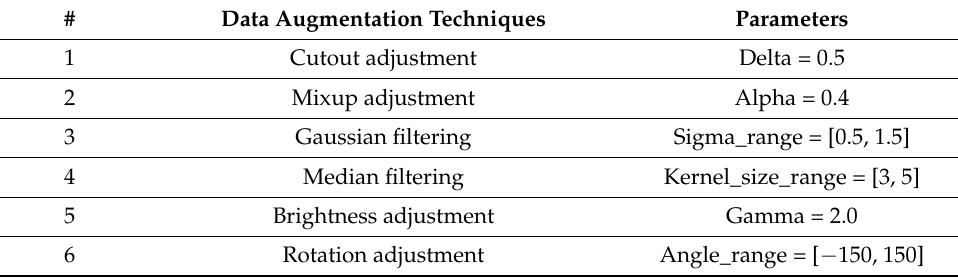
Table 2. Data augmentation techniques and parameters used in this